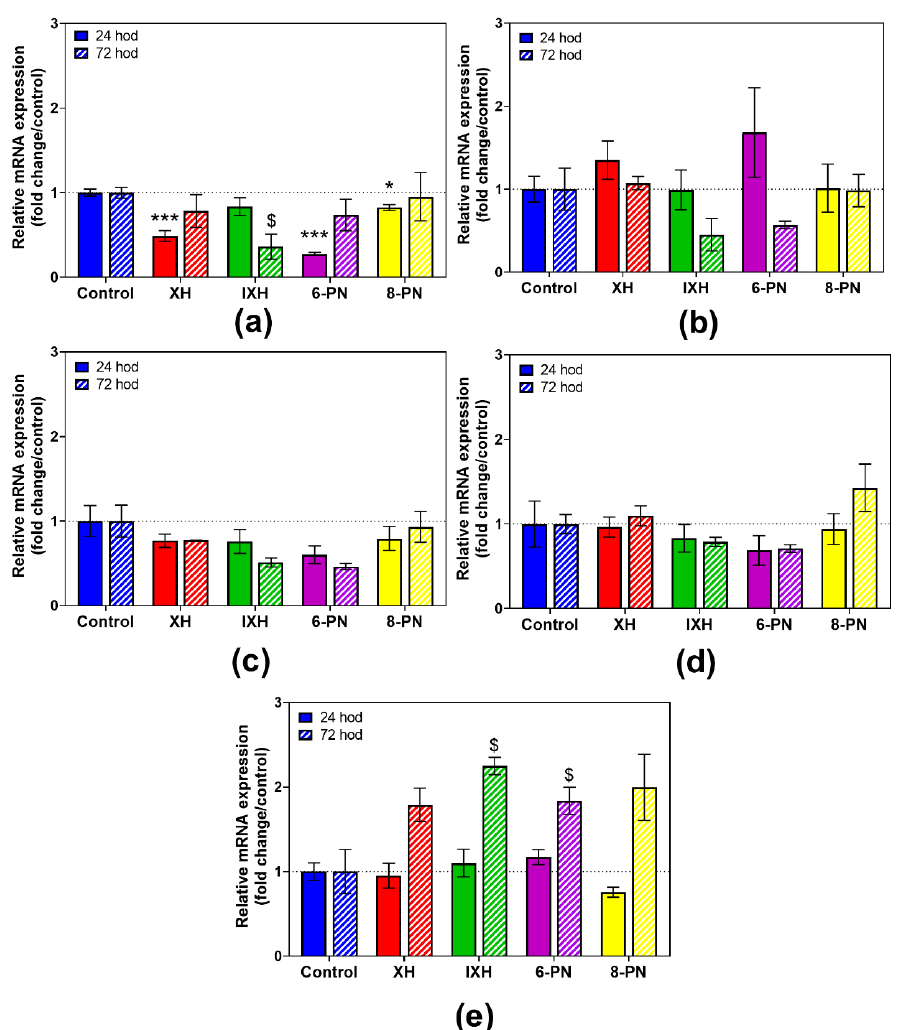
Figure 3. The e ff ect of prenylflavonoids (1 µ M) on the normalized mRNA expression of GSTA1 / 2 ( a ), Figure 3. The effect of prenylflavonoids (1 µM) on the normalized mRNA expression of GSTA1/2 ( a ), GSTP1 ( b ), SULT1A1 ( c ), COMT ( d ) and UGT1A6 ( e ) in di ff erentiated CaCo-2 cells after 24 h and 72 GSTP1 ( b ), SULT1A1 ( c ), COMT ( d ) and UGT1A6 ( e ) in differentiated CaCo-2 cells after 24 h and 72